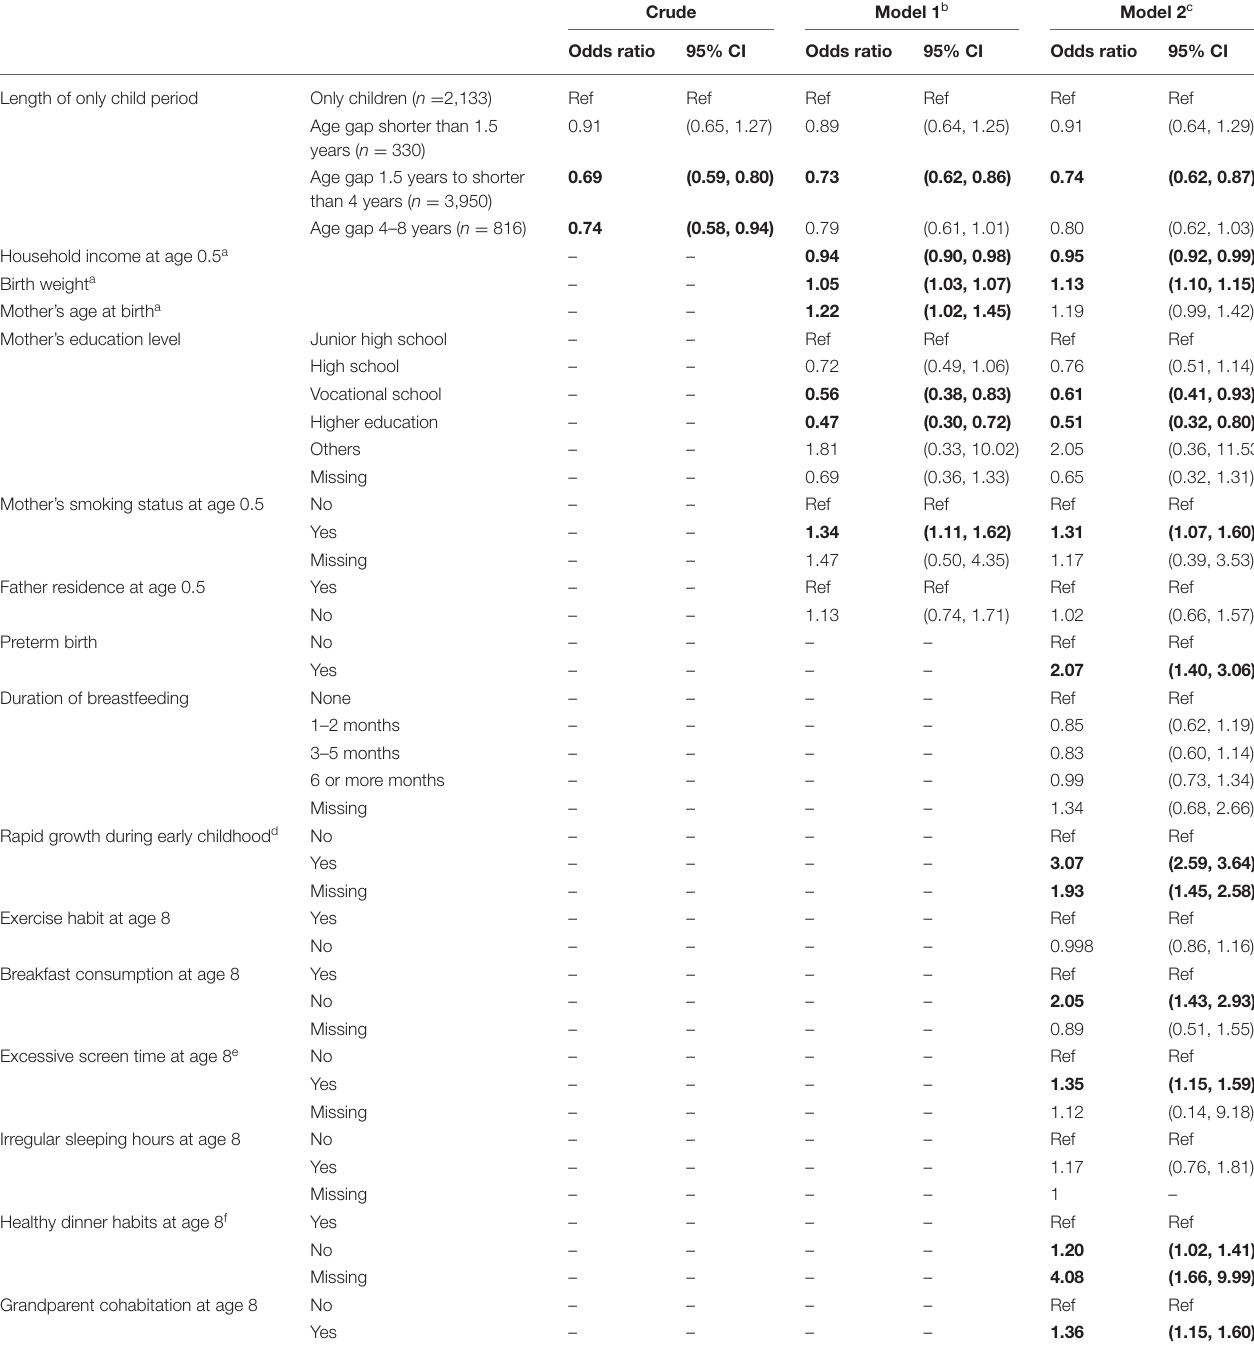
TABLE 5 | Association of length of only-child period and overweight at age 8 among girls, using logistic regression ( n =